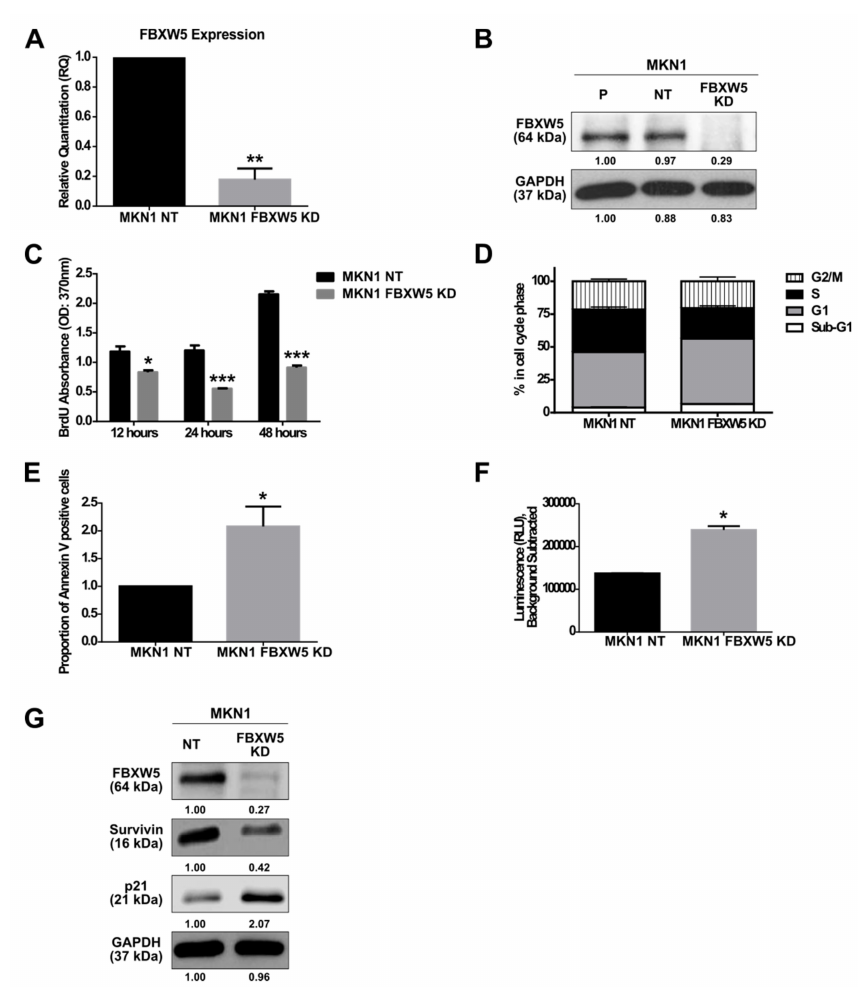
Figure 1. ( A ) Quantitative real-time PCR analysis of F-box / WD repeat-containing protein 5 (FBXW5) mRNA expression in MKN1 NT (non-targeting) and MKN1 FBXW5 KD (knockdown) cells (** p -value = 0.002). Values represent the average of three independent experiments and error bars denote standard deviations. At least three independent experiments were performed. ( B ) Western blot analysis of FBXW5 protein expression in MKN1 cells (P: Parental; NT: Non-targeting; FBXW5 KD: FBXW5 knockdown variant of MKN1). GAPDH served as the loading control. At least three independent experiments were performed. ( C ) Proliferation rates of MKN1 NT and MKN1 FBXW5 KD cells analyzed by (BrdU) proliferation assay across three time points ( p -values = 0.01, 0.0008, 1.74 × 10 − 6 , respectively). Values represent the average of three independent experiments and error bars denote standard deviations. ( D ) Cell cycle analysis of MKN1 NT and MKN1 FBXW5 KD cells in each cell cycle phase ( p -values = 0.02, 0.04, 0.01, and N.S., respectively). Values represent the average of three independent experiments and error bars denote standard deviations. At least three independent experiments were performed. ( E ) The induction of apoptosis in serum starved MKN1 NT and MKN1 FBXW5 KD cells was evaluated by flow cytometry via an Annexin V-FITC apoptosis assay. The percentage of Annexin V positive cells was calculated. Data are presented as the mean values of the fluorescent intensities from two independent experiments and error bars denote standard deviations (* p -value = 0.03). ( F ) Caspase-3 activity of serum starved MKN1 NT and MKN1 FBXW5 KD cells (* p -value = 0.03). Values represent the average luminescence intensities of two independent experiments and error bars denote standard deviations. ( G ) Western blot analyses of survivin and p21 protein expressions in MKN1 NT and MKN1 FBXW5 KD cells. GAPDH served as the loading control. At least three independent experiments were performed. * p -value ≤ 0.05, ** p -value ≤ 0.01, *** p -value ≤